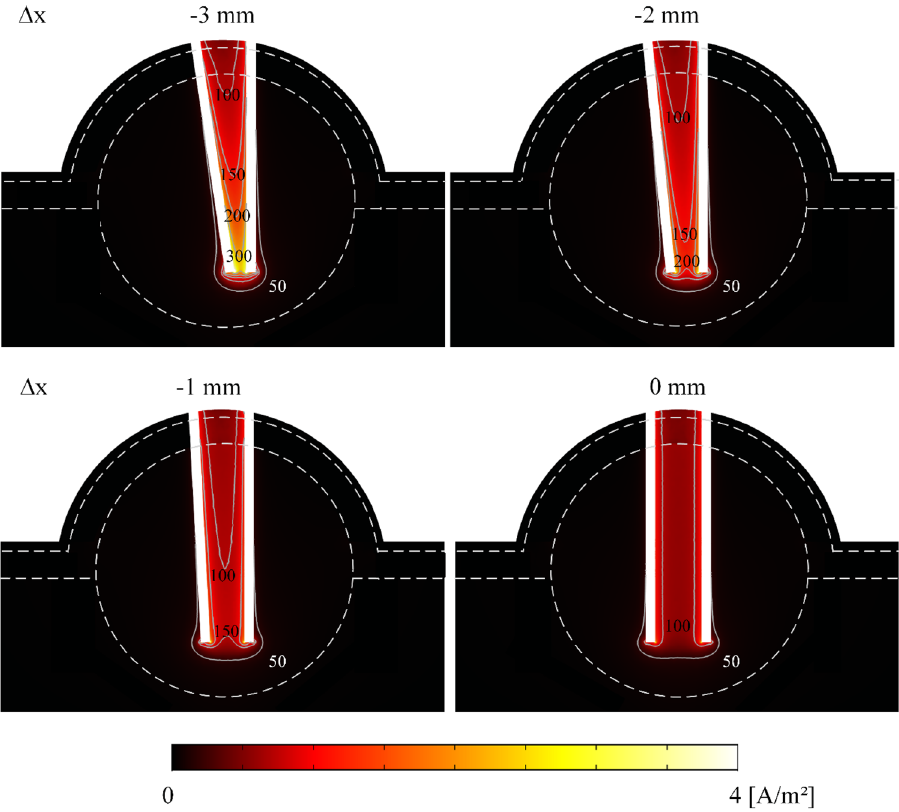
Figure 5. Electric current density distribution and electric field (kV/m) lines with inward deflection in tumor tissue case study. Electric field intensities higher than 150 kV/m are observed in a large tissue area for Δx smaller than −1 mm. The cut planes were generated by COMSOL Multiphysics v.5.1 (COMSOL Inc., Stockholm, Sweden; https:// www. comsol. com/ comsol- multi physi